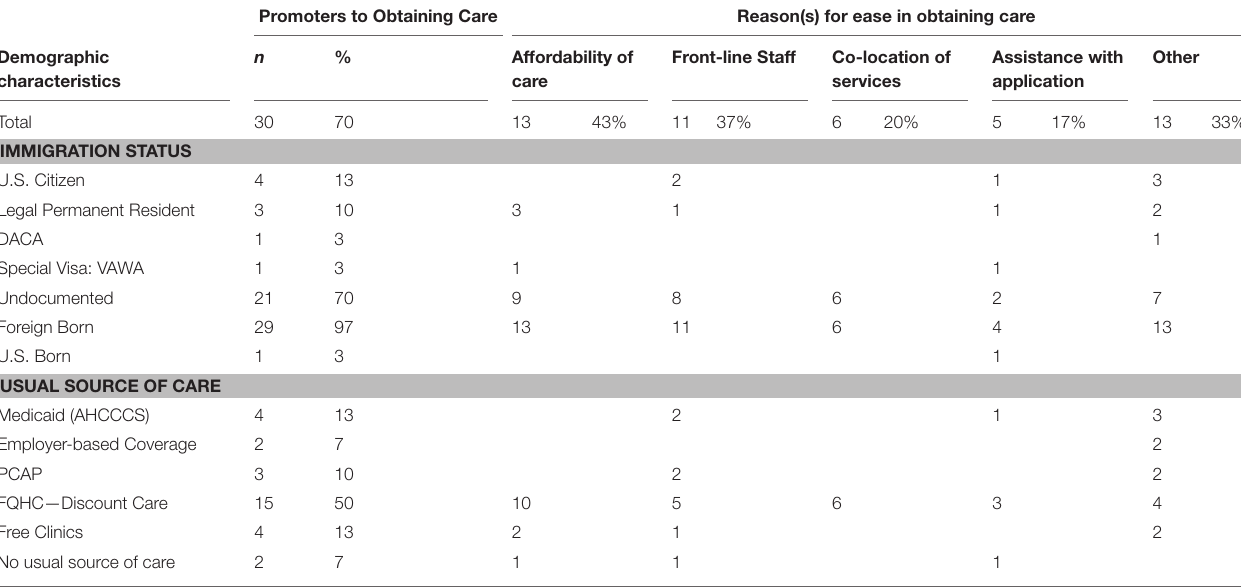
TABLE 3 | Promoters to obtaining health coverage a and selected demographic characteristics ( n =